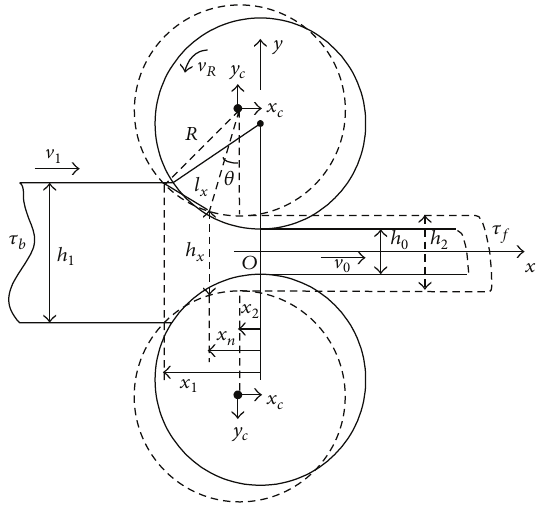
Figure 1: The dynamic deformation process of